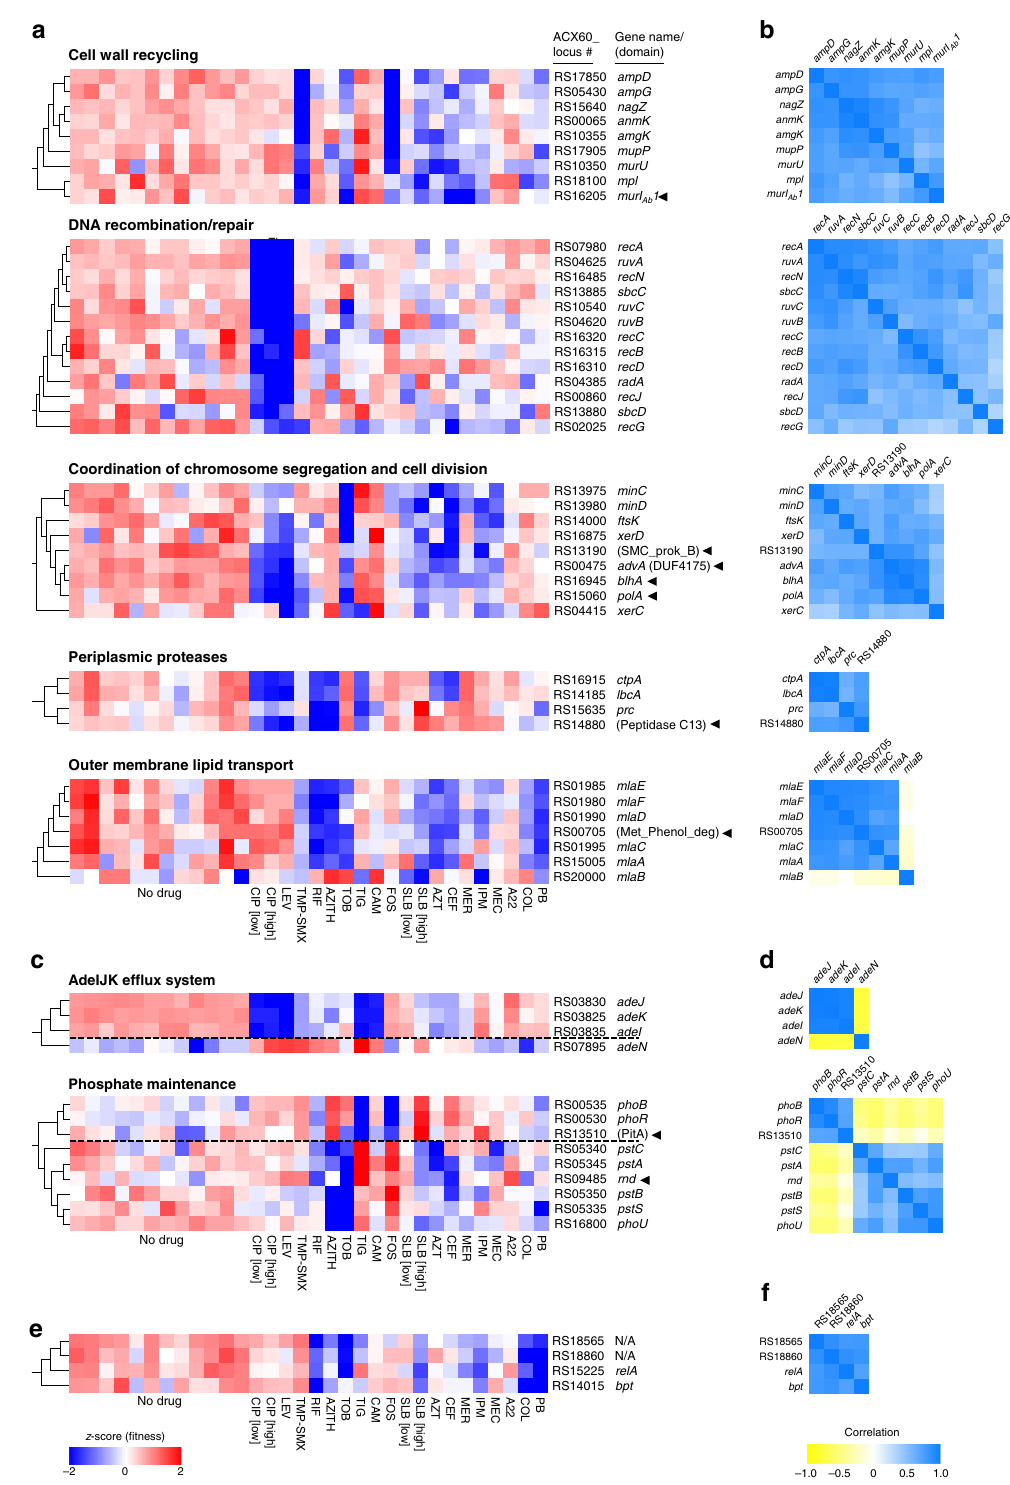
Fig. 2 Genes with interconnected functions show correlated phenotypic signatures. a – f Genes within a shared functional pathway show relationships in their Tn-seq fi tness signatures. a , c Heat maps (using blue-white-red scale at bottom) show normalized Tn-seq fi tness in z -scored units for mutants in each gene (rows) grown in distinct conditions (columns). Characterized/annotated genes were fi rst placed into shared functional pathways (Methods). We next identi fi ed additional genes (arrowheads), many of which were uncharacterized/unannotated, that correlate with each pathway by using hierarchical clustering with the entire set of A. baumannii phenotypic signatures. Parentheses denote domains identi fi ed from NCBI conserved domain database (CDD) 46 . In c , dashed black lines separate genes with opposing regulatory effects. b , d Heat maps (using yellow-white-blue scale at bottom) show Pearson correlation coef fi cient ( r ) matrices measuring relatedness of the corresponding Tn-seq fi tness signatures in ( a ). Positive and negative r indicate correlation and anticorrelation, respectively. e , f Phenotypic signatures correlating with pAB3-encoded ACX60_RS18565. Tn-seq fi tness ( e ) and correlations ( f ) are shown as above. N/A, no gene name or predicted protein domain. Source data are provided as a Source Data fi